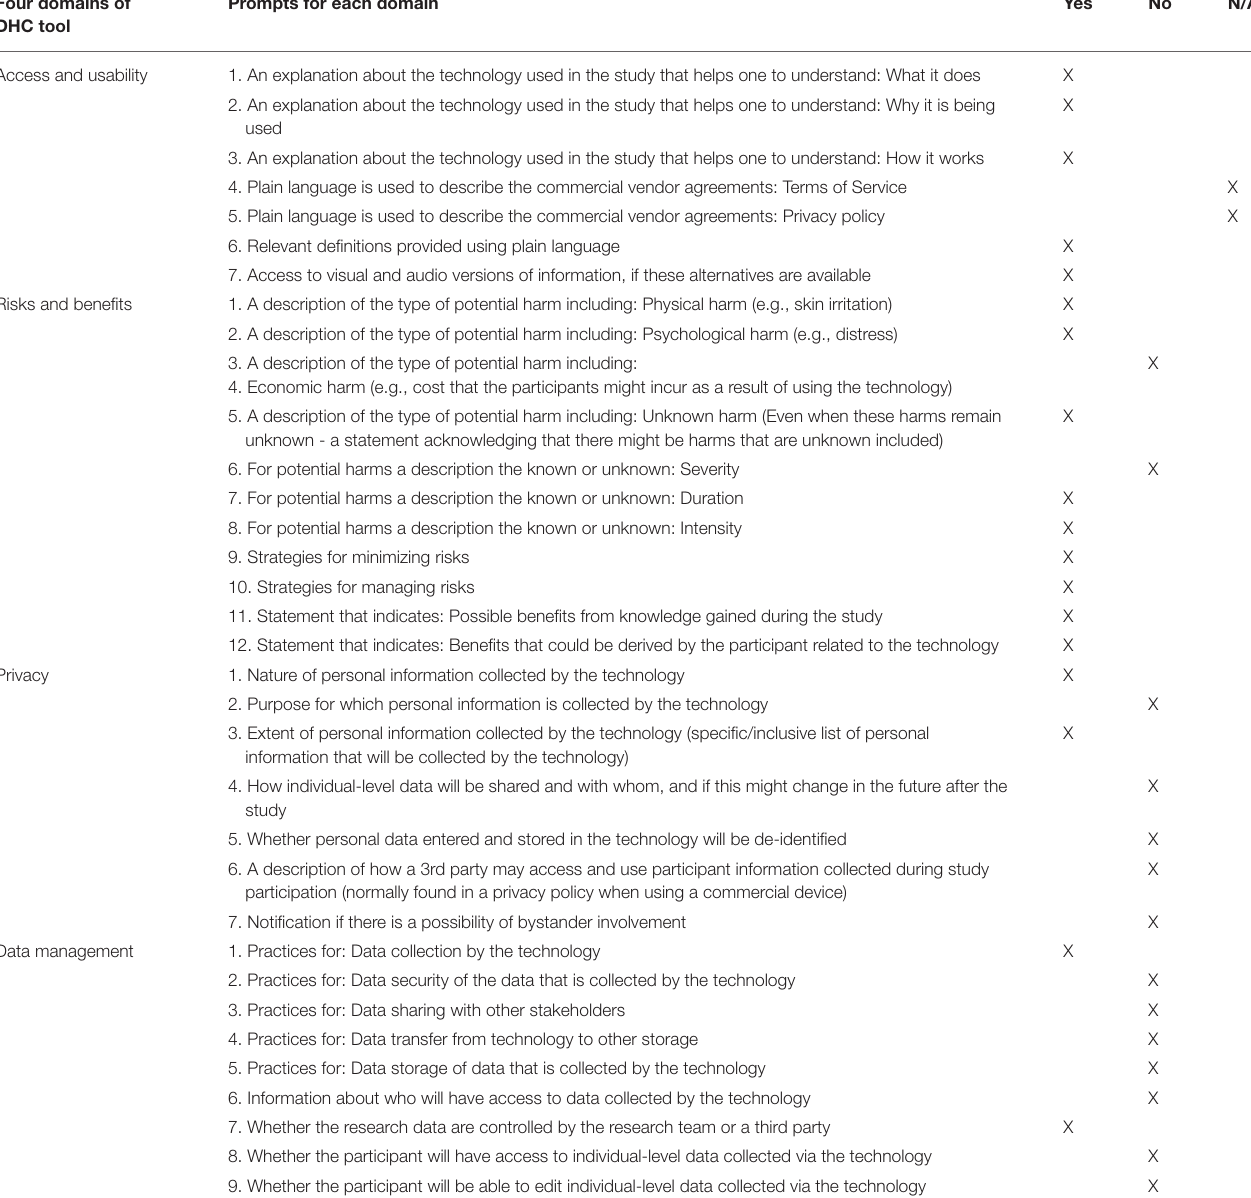
TABLE 3 | Digital health checklist consent blueprint: ethical principle “respect for persons” across four domains. Four domains of DHC